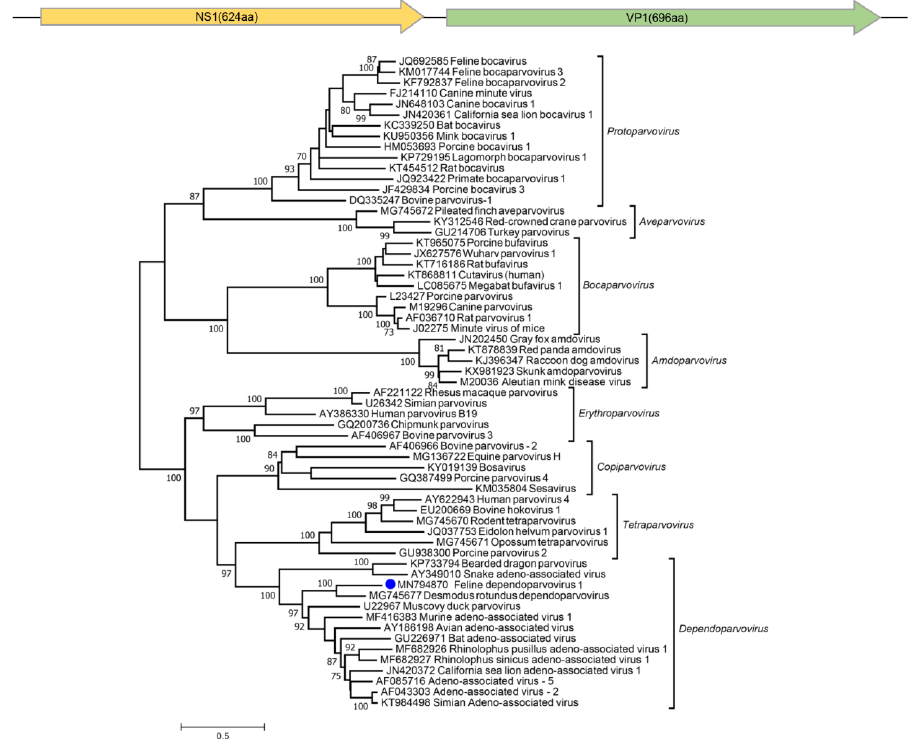
Figure 4. Two main ORFs of the new feline dependoparvovirus and maximum-likelihood phylogenetic tree of the complete NS1 protein sequences of subfamily Parvovirinae . The new dependoparvovirus identified in cat is shown with a blue circle.